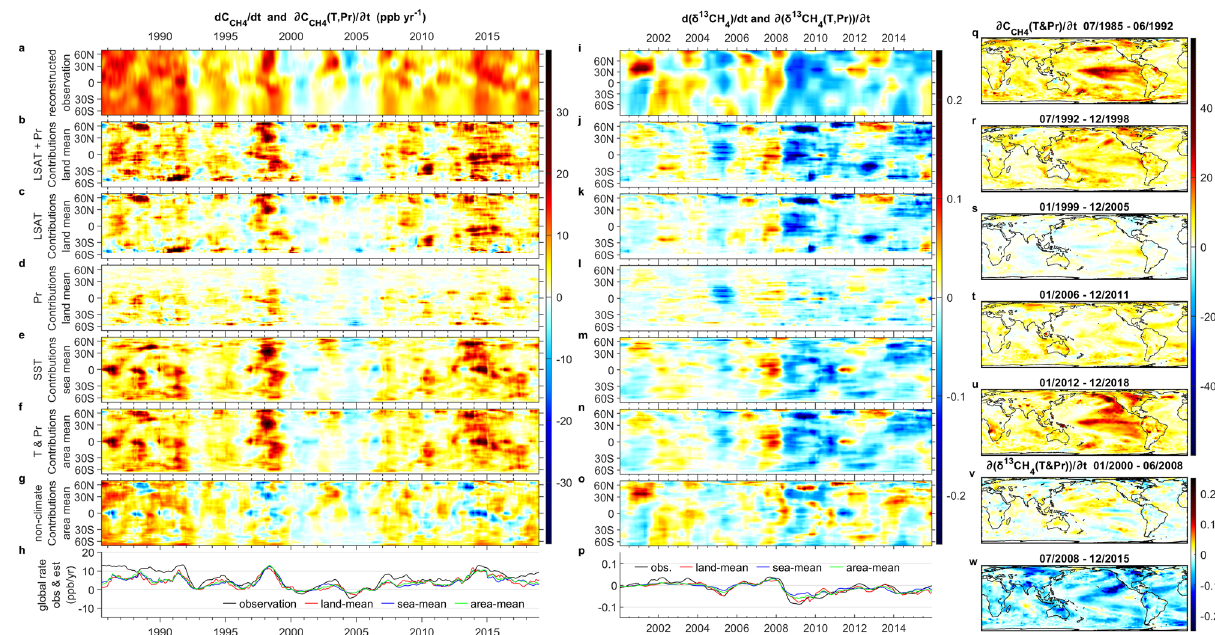
Fig. 1 Reconstructed observation (obs) of dC CH4 / dt (ppb yr − 1 ), d ( δ 13 CH 4 )/ dt ( ‰ yr − 1 ) and respective estimated (est) c - and nc - contributions. a dC CH4 /dt (ppb yr − 1 ) and i d ( δ 13 CH 4 ) /dt for observations. (est) c- and nc- contributions: b – f , h , p – u for ∂ C CH4 ( T,Pr ) / ∂ t and i – n , p , v – w for ∂ ( δ 13 CH 4 ( T,Pr )) / ∂ t. a – g , i – o zonal mean versus latitude (equal area) and time (years CE): exclusive land ( b – d , j – l ), sea ( e , m ), or area-weighted mean ( f , n for T & Pr and g , o for nc- contributions); h , p global mean ; and q – w temporal mean . Since the timings of estimated climate-contributions refer to causes that lead to the observed consequences, their difference ( g , o ) still shows substantial interannual